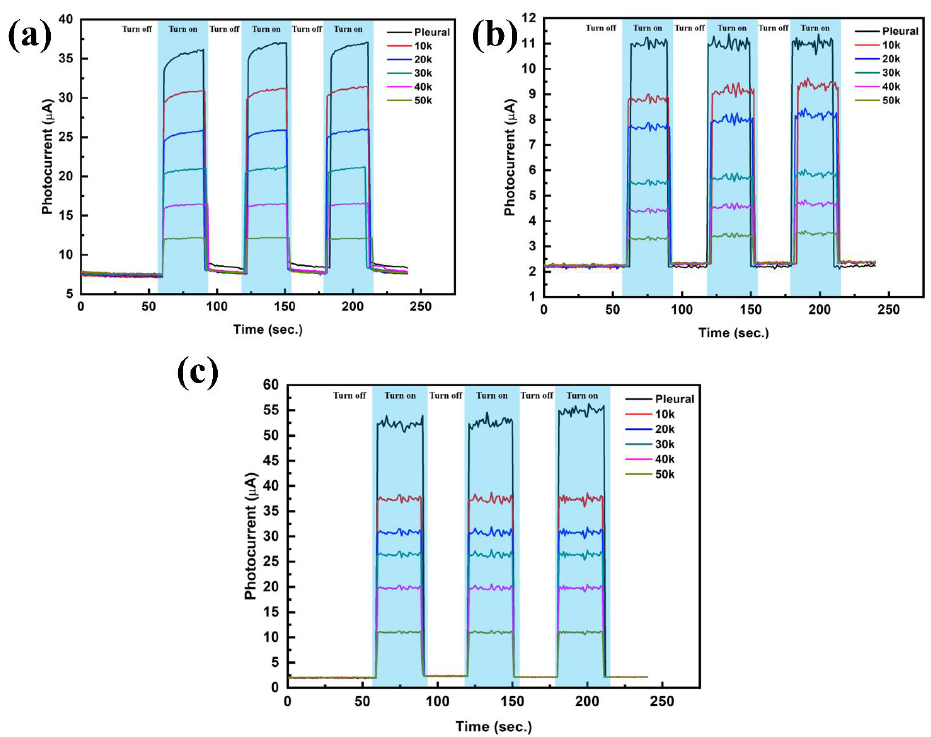
Figure 9. P. ( a ) Photocurrent responses of A549 under different cell numbers, ( b ) Photocurrent responses of NCI-H460 under different cell numbers and ( c ) Photocurrent responses of NCI-H520 under different cell numbers .